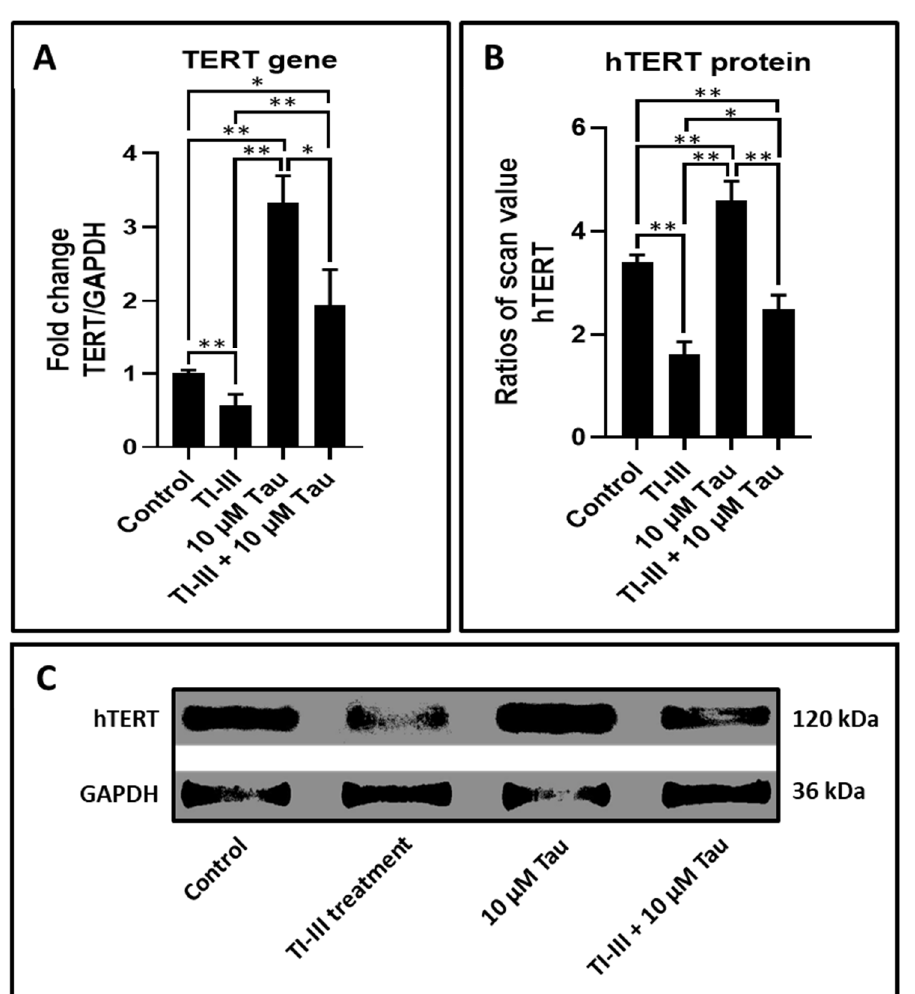
Figure 3. Taurine upregulates gene expression of TERT and protein levels of hTERT in DPSCs. ( A ) Comparative gene expression analysis of TERT with and without taurine treated DPSCs and telomerase inhibited DPSCs. ( B , C ) Whole cell extracts were evaluated by using the western blot method to decide the protein expression levels of hTERT in DPSCs. The graphs show the ratios of band densities of hTERT. ns: not significant, * p < 0.05, ** p < 0.01. Tau: Taurine, TI-III: telomerase inhibitor III, TERT/hTERT: human telomerase reverse transcriptase .